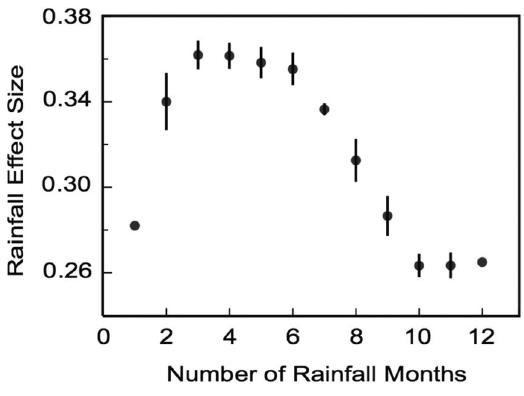
Figure 2. The moving average dependence of the effect size (standardized coefficients in Table 2) for the rainfall variable versus number of months with rain prior to data collection. The moving interval over which averaging is undertaken contains three consecutive values of the coefficients from Table 2. The first and the last points are added to this dependence directly from Table 2 (because these edge points are not included into the moving average dependence with the three-point moving interval). Error bars calculated as the errors of the mean within the moving interval are shown for each of the moving average points. Note, this figure shows the magnitude of the effect size, and the actual effect of rainfall on cortisol levels is